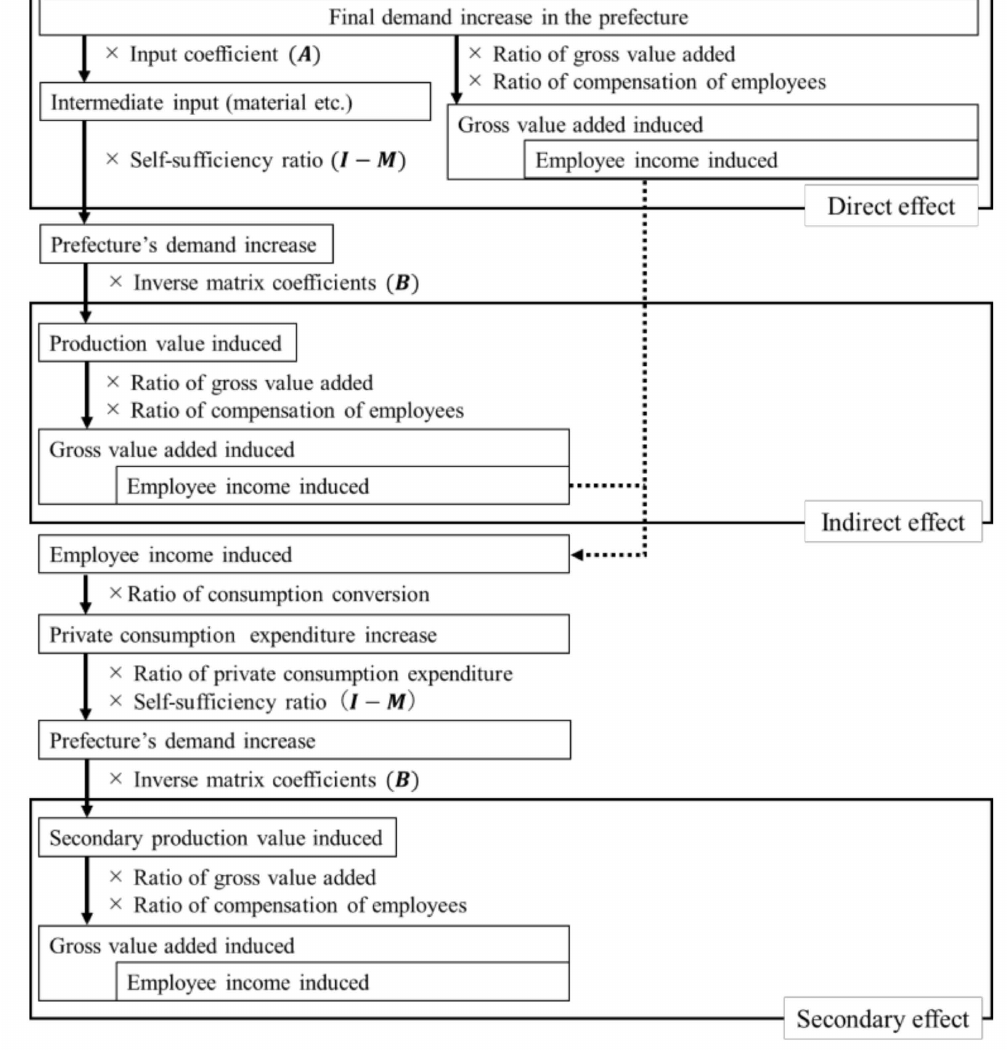
Figure 3. The economic impact evaluation